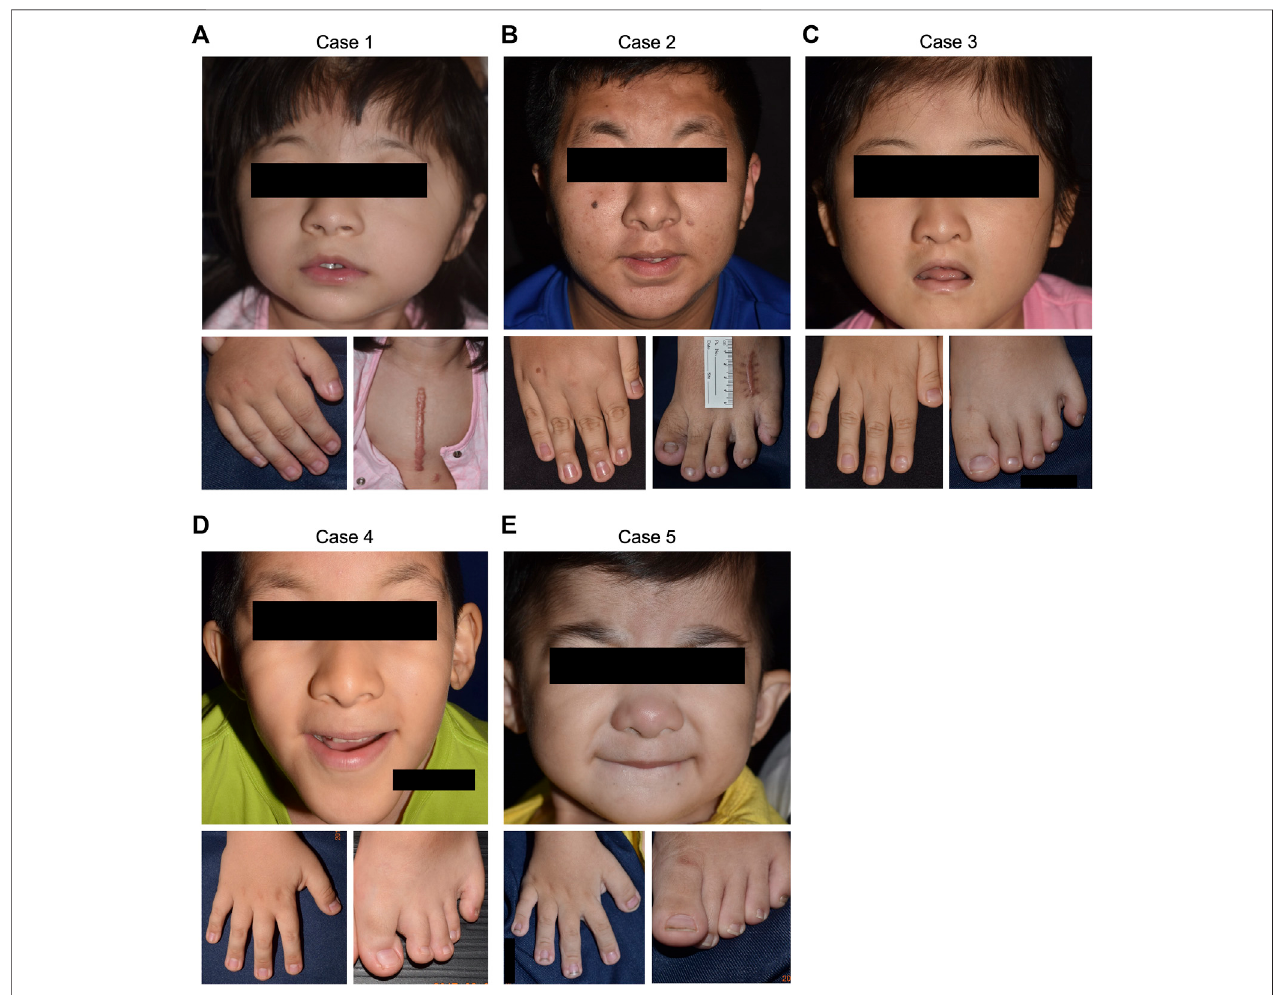
FIGURE 2 | Clinical manifestations of the fi ve RSTS cases. Positive fi ndings of common RSTS characteristics, including distinctive facial features, and broadened thumbs and halluces, were noted in all of the enrolled cases. (A) case 1. (B) case 2. (C) case 3. (D) case 4. (E) case